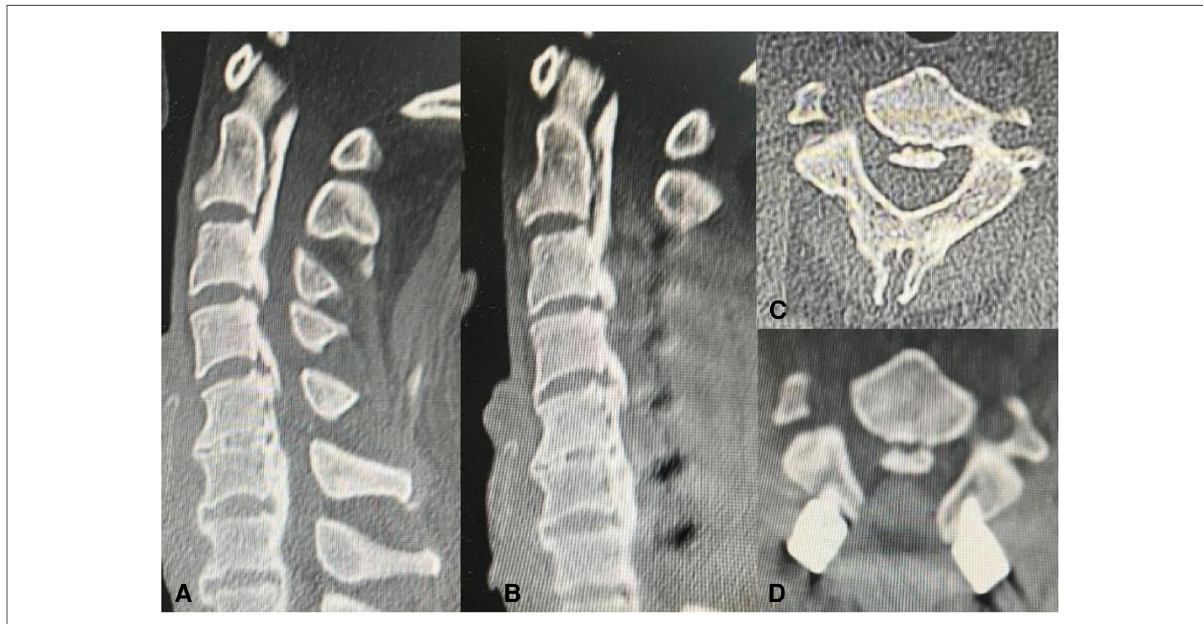
FIGURE 3 CT scans showing the extent of bone removed by C2 partial laminectomy (C2-PL). ( A,C ) showing the CT image of the cervical spine before the surgery. ( B,D ) showing the CT image of the cervical spine after the